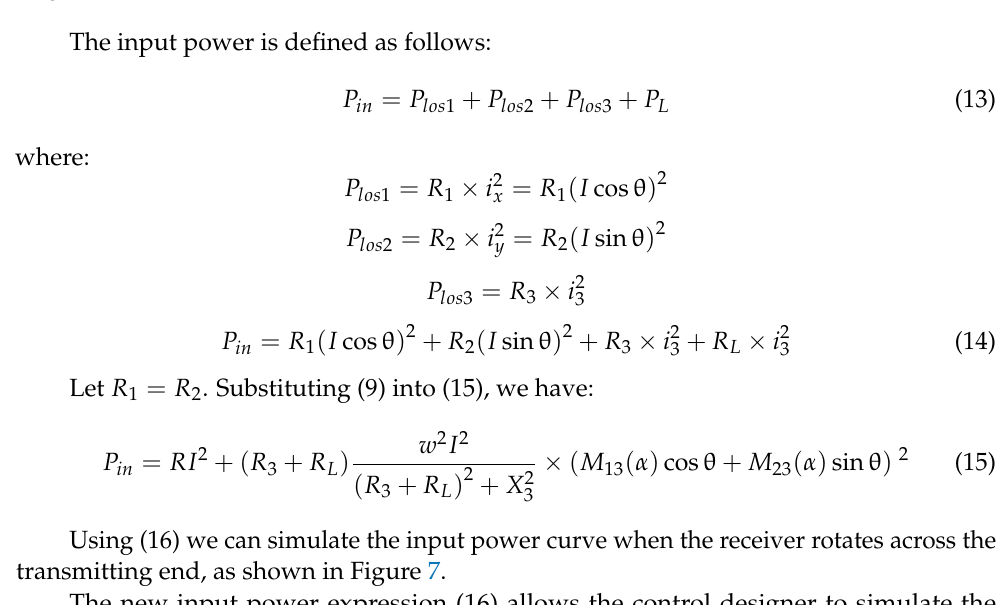
Figure 6. Polar plot of the load power when the receiver is placed at 45 ◦ in the presence of a rotating magnetic